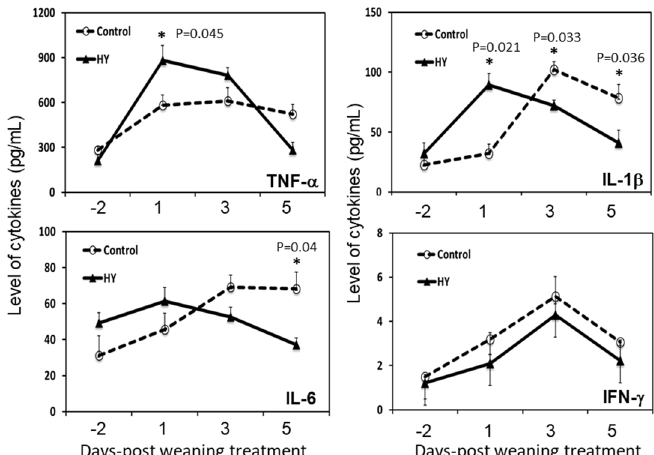
Figure 2. E ff ects of HY supplementation in calf starters on the changes in the levels of pro-inflammatory cytokines (TNF- α , IL-1 β , IL-6, and IFN- γ ) in calves after weaning. The dotted lines represent the calves fed calf starter without HY (control diet (CON)), and the solid lines represent the calves fed calf starter supplemented with hydrolyzed yeast (HY). The levels of pro-inflammatory cytokines in the blood were assessed via an ELISA assay. The asterisks indicate a significant di ff erence between the dietary groups ( p < 0.05). Data are presented as the mean ± SE. Day 0 post-weaning represents the beginning of the weaning procedure (42 days of age). TNF- α , tumor necrosis factor α ; IL-1 β , interleukin 1 β ; IL-6, interleukin 6; and IFN- γ , interferon γ .